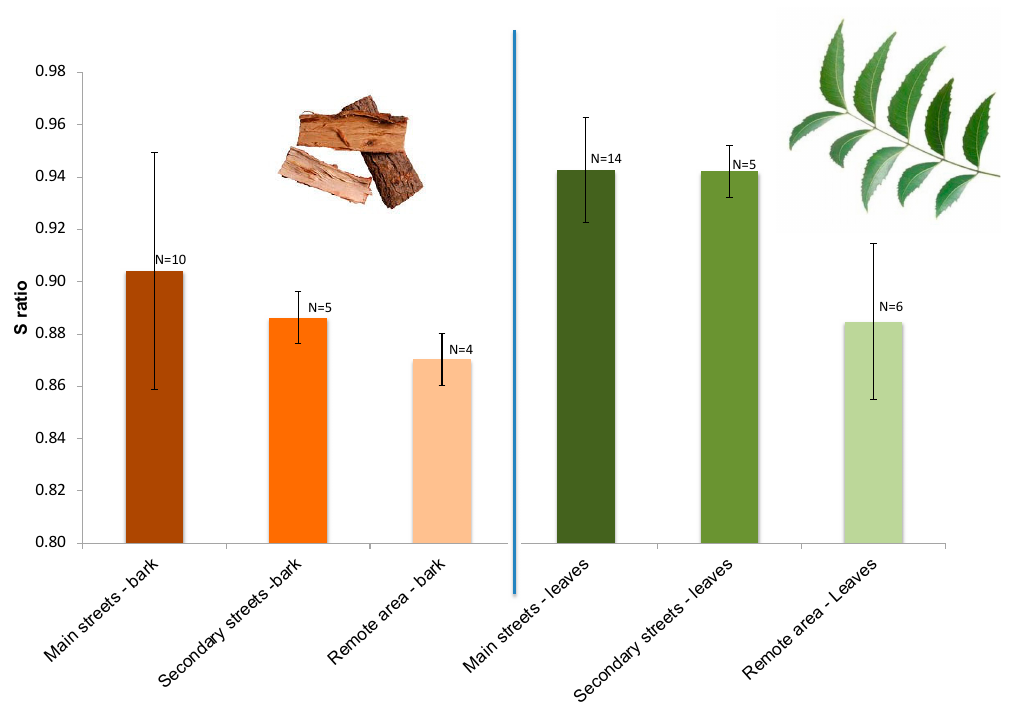
Figure 7. Mean S-ratio (all campaigns together) for each site type. Error bars represent the standard deviation.